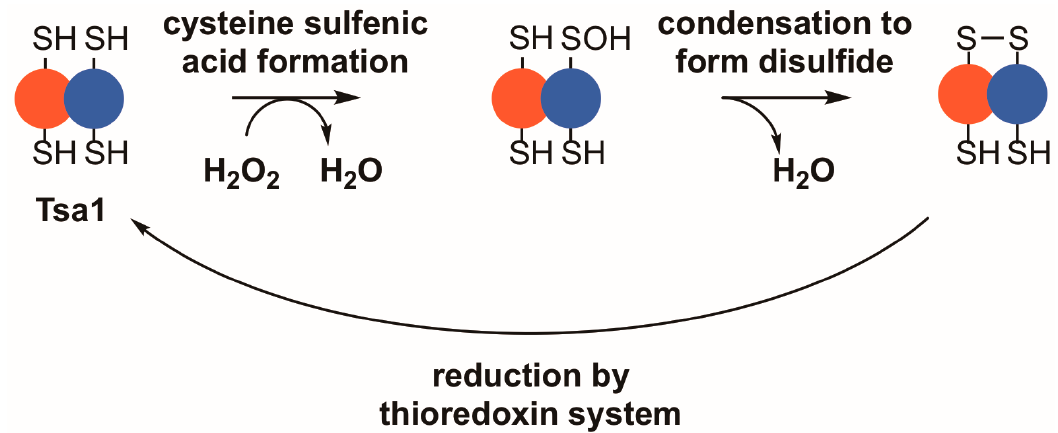
Figure 1. Tsa1 and other typical 2-Cys peroxiredoxins detoxify peroxides through a thiol-dependent, disulfide-based mechanism. Upon binding a peroxide, Tsa1 is oxidized on its peroxidatic cysteine to form a cysteine sulfenic acid (–SOH). Subsequently, the sulfenic acid condenses with the thiol in the resolving cysteine to form a disulfide bond. Thioredoxins reduce the resulting disulfide bond to complete the catalytic cycle.